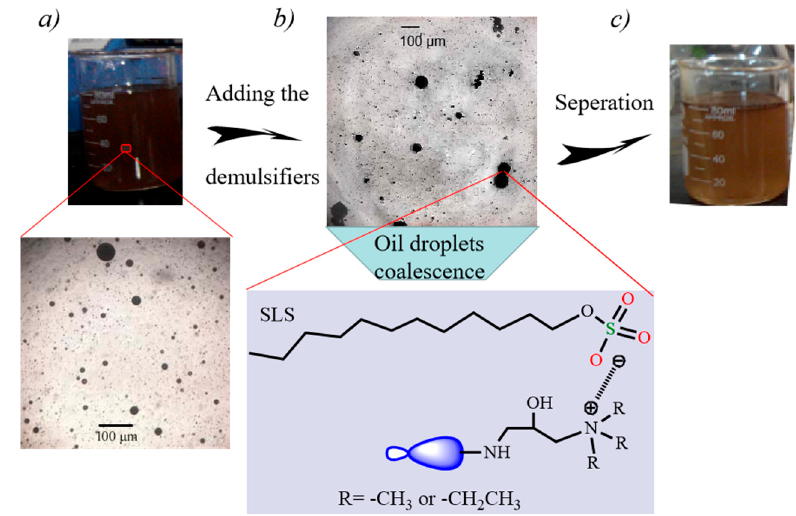
Figure 7. The demulsification mechanisms of H-PAMAM-HA and H-PAMAM-ETA. ( a ) The emulsion and its microstructure obtained under microscope; ( b ) oil droplet coalescence and possible neutralization between the surfactant and the demulsifier; ( c ) the separation process.